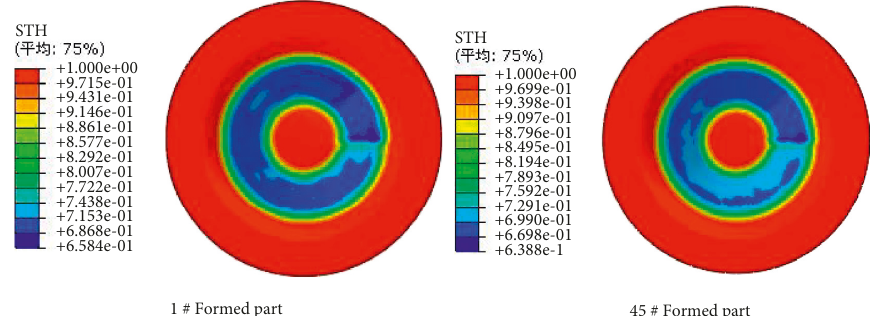
Figure 10: Cloud diagram of thickness distribution under two sets of process parameters and corresponding friction coefficients: (a) 1# formed part and (b) 45# formed part.